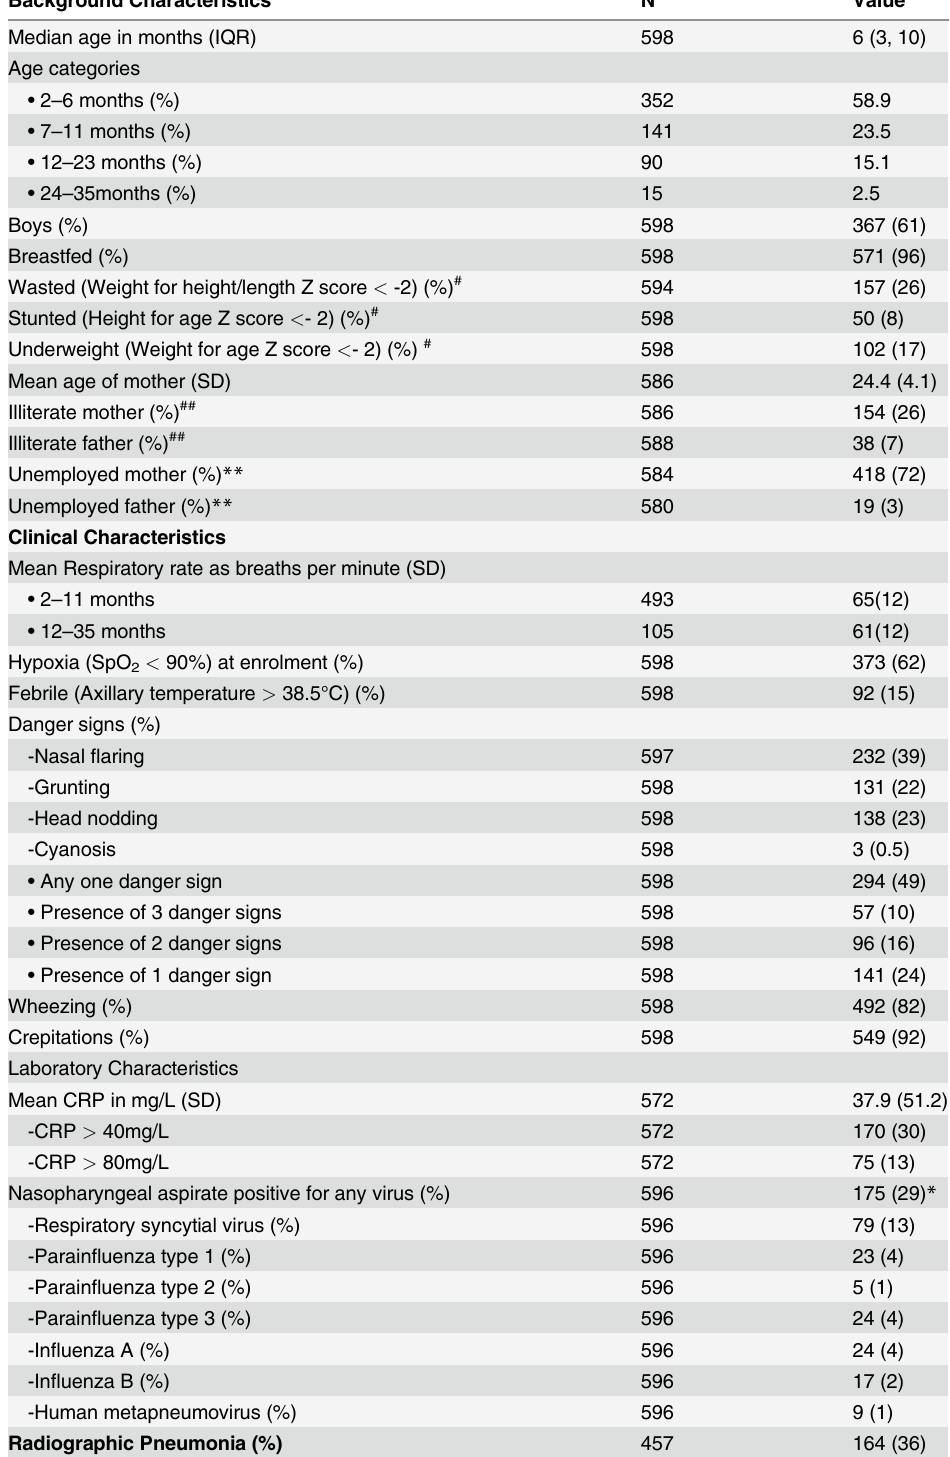
Table 1. Baseline Characteristics of children ages 2 – 35 months with WHO defined severe